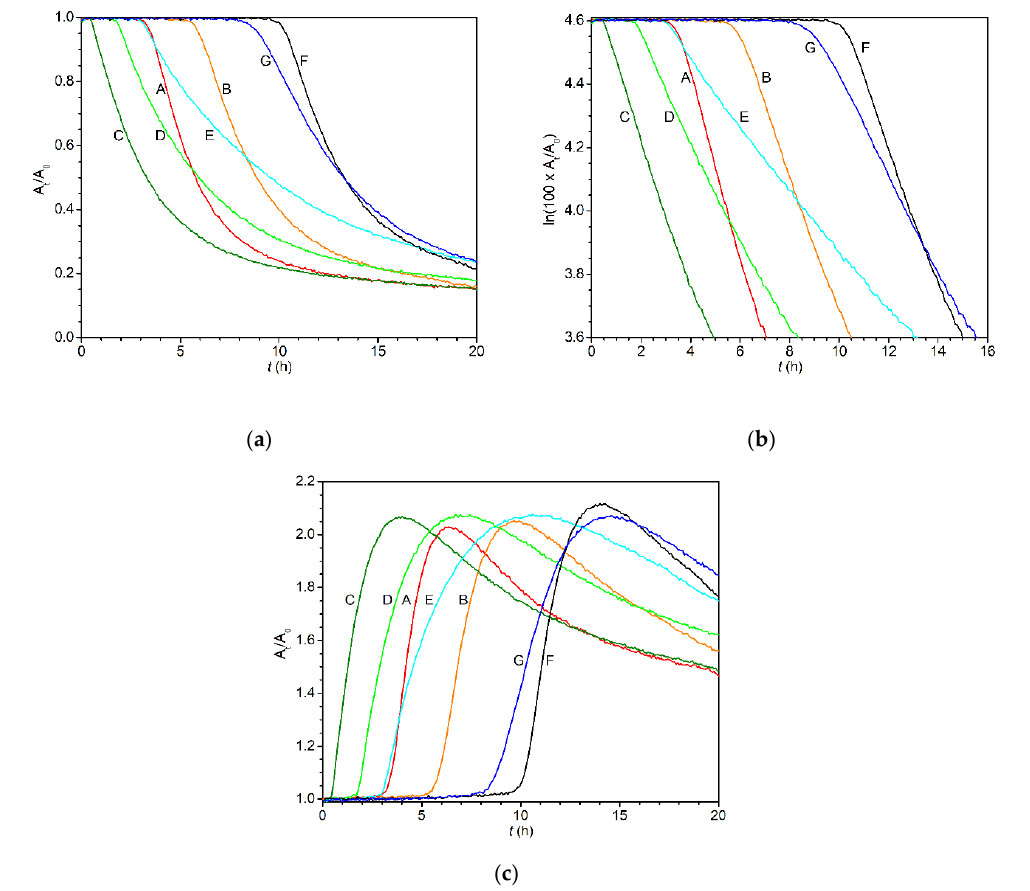
Figure 4. Time development of the infrared band: ( a ) at 3008 cm − 1 in linear scale; ( b ) at 3008 cm − 1 in logarithmic scale; ( c ) at 989 cm − 1 in linear scale. A: 1 /0.1 wt.%, B: 1 /0.06 wt.%; C: 3 /0.1 wt.%, D: 3 /0.06 wt.%, E: 3 /0.03 wt.%, F: 4 /0.1 wt.%, G: 4 /0.06 wt.%. Table 5. Kinetic parameters for ferrocene derivatives.